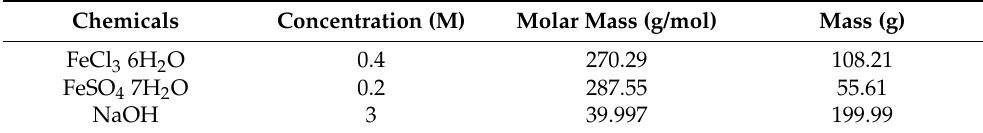
Table 2. Stock solution